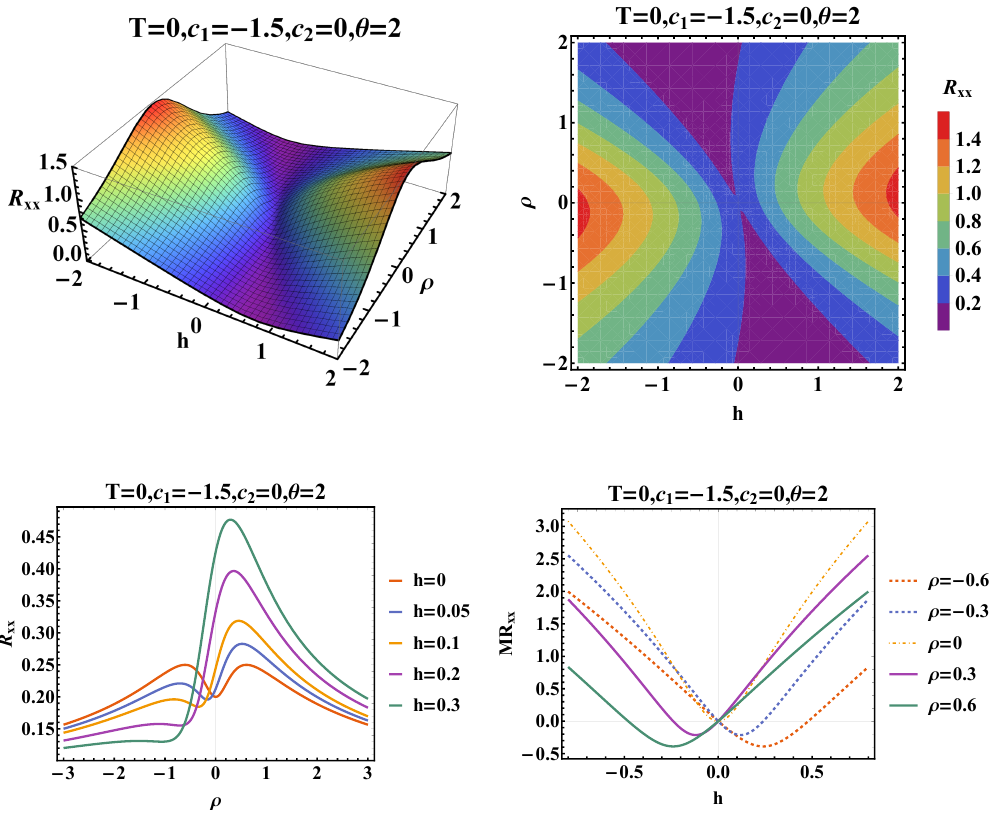
Figure 8 . Upper left: R xx as a function of h and ρ . Upper right: contour plot of R xx . Lower left: R xx vs ρ with h = 0 , 0 . 05 , 0 . 1 , 0 . 2 , 0 . 3 . Lower right: MR xx vs h with ρ = − 0 . 6 , − 0 . 3 , 0 , 0 . 3 , 0 . 6 . We set T = 0 , c 1 = − 1 . 5 , c 2 = 0 and θ = 2 .